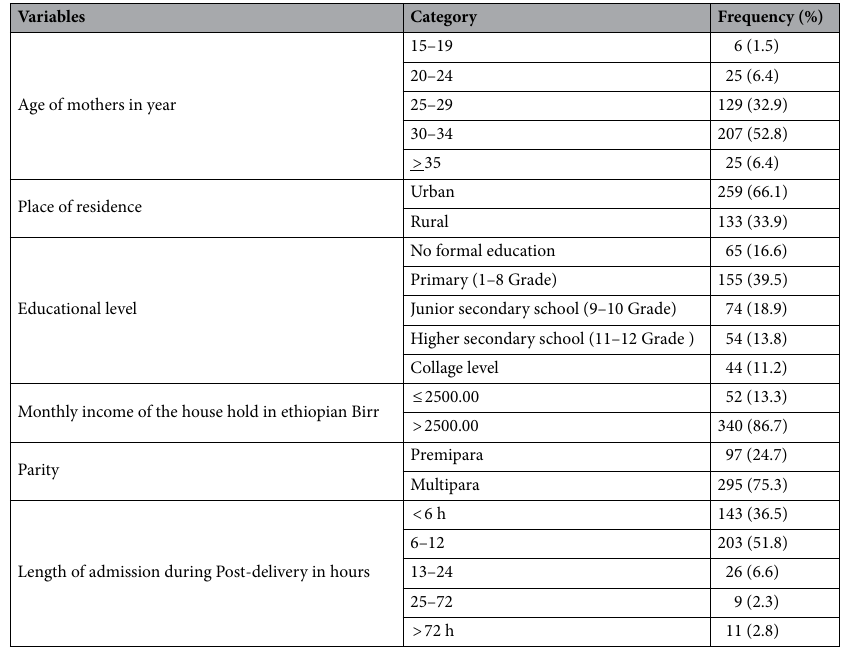
Table 1. Socio-demographic characteristics of mothers of newborns attending neonatal intensive care unit of Hawassa University Comprehensive Specialized Hospital, Hawassa, Ethiopia, March 2021–November 2021 (N = 392).